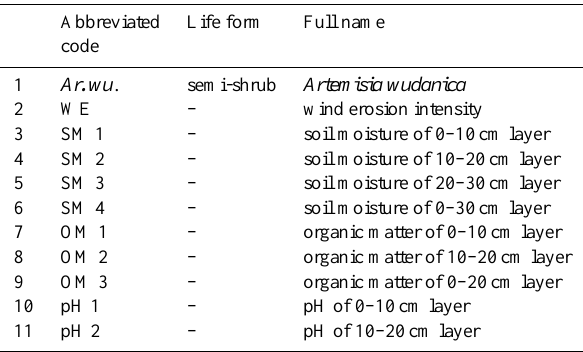
Table 1. Abbreviated codes for the species and environmental fac- tors.